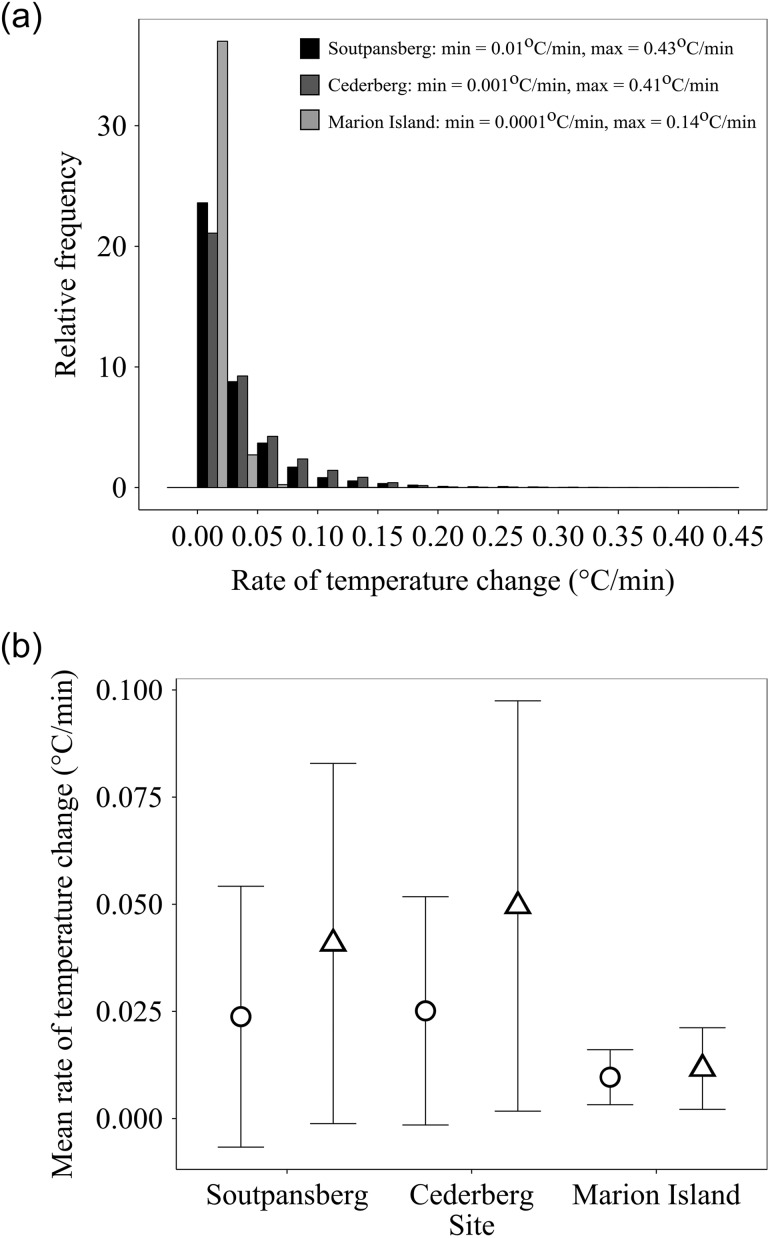
(a) Relative frequency of occurrence of rates of temperature change 1 cm
below the surface of soils for single sites at comparable altitudes for Marion Island
(sub-polar, light grey bars, 800 m above sea level), the Cederberg transect (dark
grey, green bars, 900 m above sea level) and the Soutpansberg transect (sub-tropical,
black bars, 800 m above sea level). Minimal and maximal rates of temperature change
for each site are given in the key. (b) Mean rate of temperature change
at each site for increasing (open triangles) and decreasing temperatures (open
circles). Mean rate of change differed significantly among sites [Kruskal–Wallis H
test (2, n = 62 066) = 8579.65, P < 0.001] and
between increasing and decreasing temperatures [Kruskal–Wallis H test (2,
n = 62 066) = 3544.11, P < 0.001]. Vertical
bars are standard deviation.